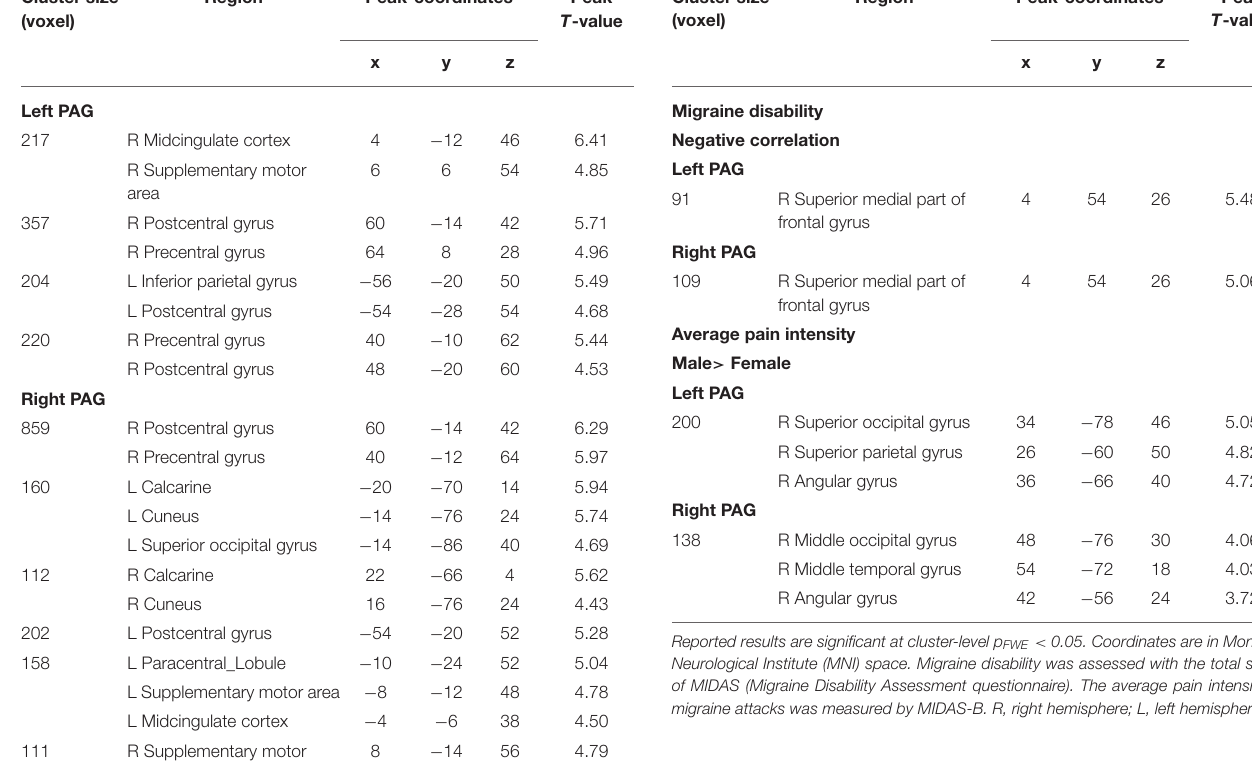
TABLE 2 | Brain regions showing a significantly stronger PAG–FC in female migraineurs compared to males. Cluster size (voxel)